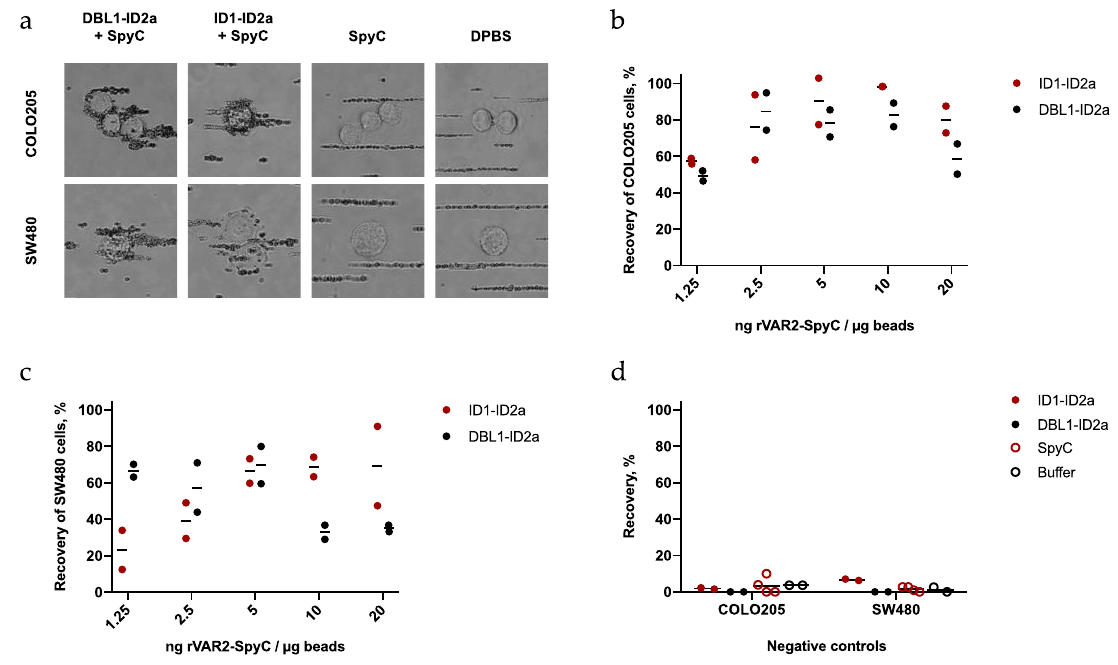
Figure 2 . Bead binding to cancer cells in buffer is dependent on rVAR2-SpyC-coating. ( a ) Representative bright field images of COLO205 and SW480 cells incubated with beads coated with DBL1-ID2a-SpyC, ID1-ID2a-SpyC, SpyC, or DPBS. Images are taken with 40x objective, CellCelector (Automated Lab Solutions). ( b ) and ( c ) Recovery of COLO205 or SW480 cells from PF buffer using various amounts of rVAR2-SpyC per µg beads. Lines represent mean values. ( d ) Capture efficiency for the negative control beads prepared with non-biotinylated rVAR2, SpyC, or buffer. Lines represent mean values of duplicates or quadruplicates.